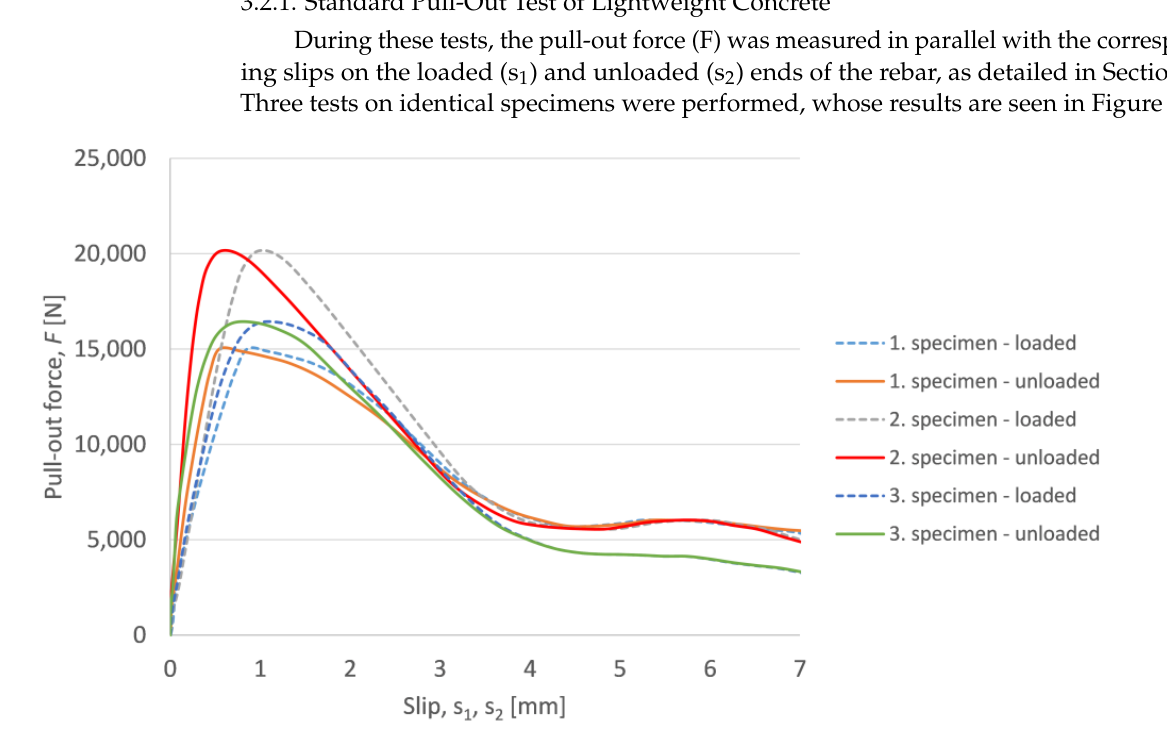
Figure 7. Standard pull-out test results for lightweight concrete (Pull-out force (F) – slip (s) curve).